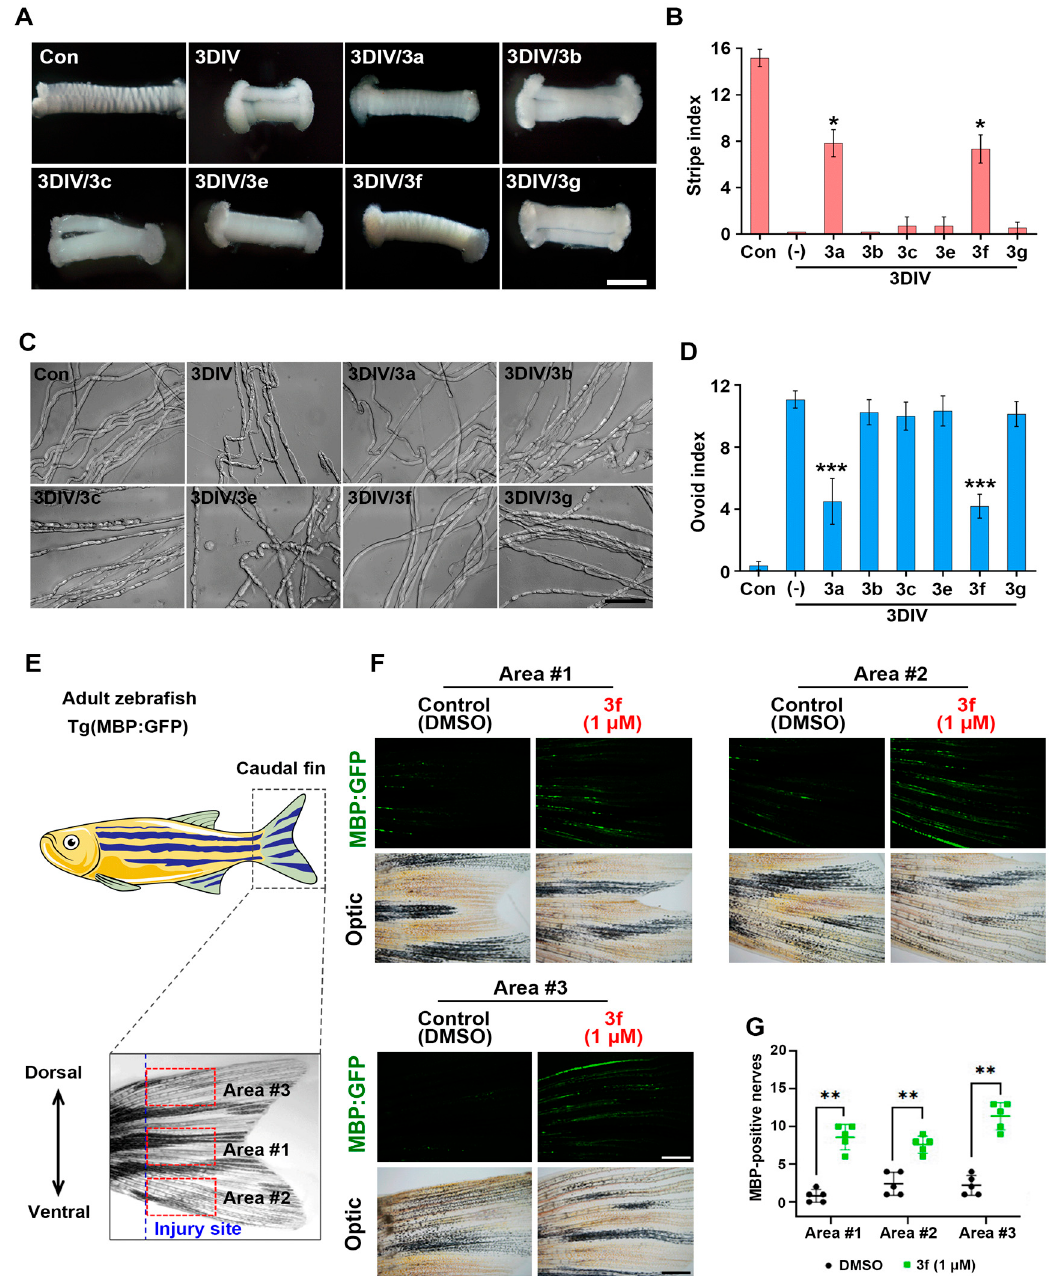
Figure 4. Ex vivo and in vivo efficacy of CAH derivatives against PND. ( A ) Sciatic nerve explant culture was used for evaluating ex vivo efficacy. Transverse stripes of sciatic nerve explants in the presence or absence of compounds of 100 µM were observed and photographed under a stereomi- croscope for three days in vitro (3DIV). Scale bar, 50 µm. The compounds were 3a , 3b , 3c , 3e , 3f , and 3g . ( B ) The number of transverse stripes in a 2 mm-long sciatic nerve was defined as stripe index and measured by counting under a stereomicroscope (n = 3 mice). ( C ) Ovoid-shaped myelin formation appeared in the sciatic nerve fibers cultured for 3DIV with or without treatment of the compounds. ( D ) The ovoid index was obtained by counting the ovoid-shaped myelin in 200 µm-long sciatic nerve fibers under a differential interference contrast (DIC) filtered microscope. Scale bar, 50 µm. ( E ) In vivo PND model using [Tg(mbp:eGFP)] zebrafish are visualized. ( F ) MBP:eGFP fluorescence in the caudal fin (green) with 3f treatment of 1 µM for 10 days was observed under a stere- omicroscope. Scale bar, 0.25 mm. ( G ) The number of intact GFP fluorescence was counted in three areas (1 × 1 mm 2 ) of the distal part of the injury. * p < 0.05, ** p < 0.01, and *** p < 0.001.